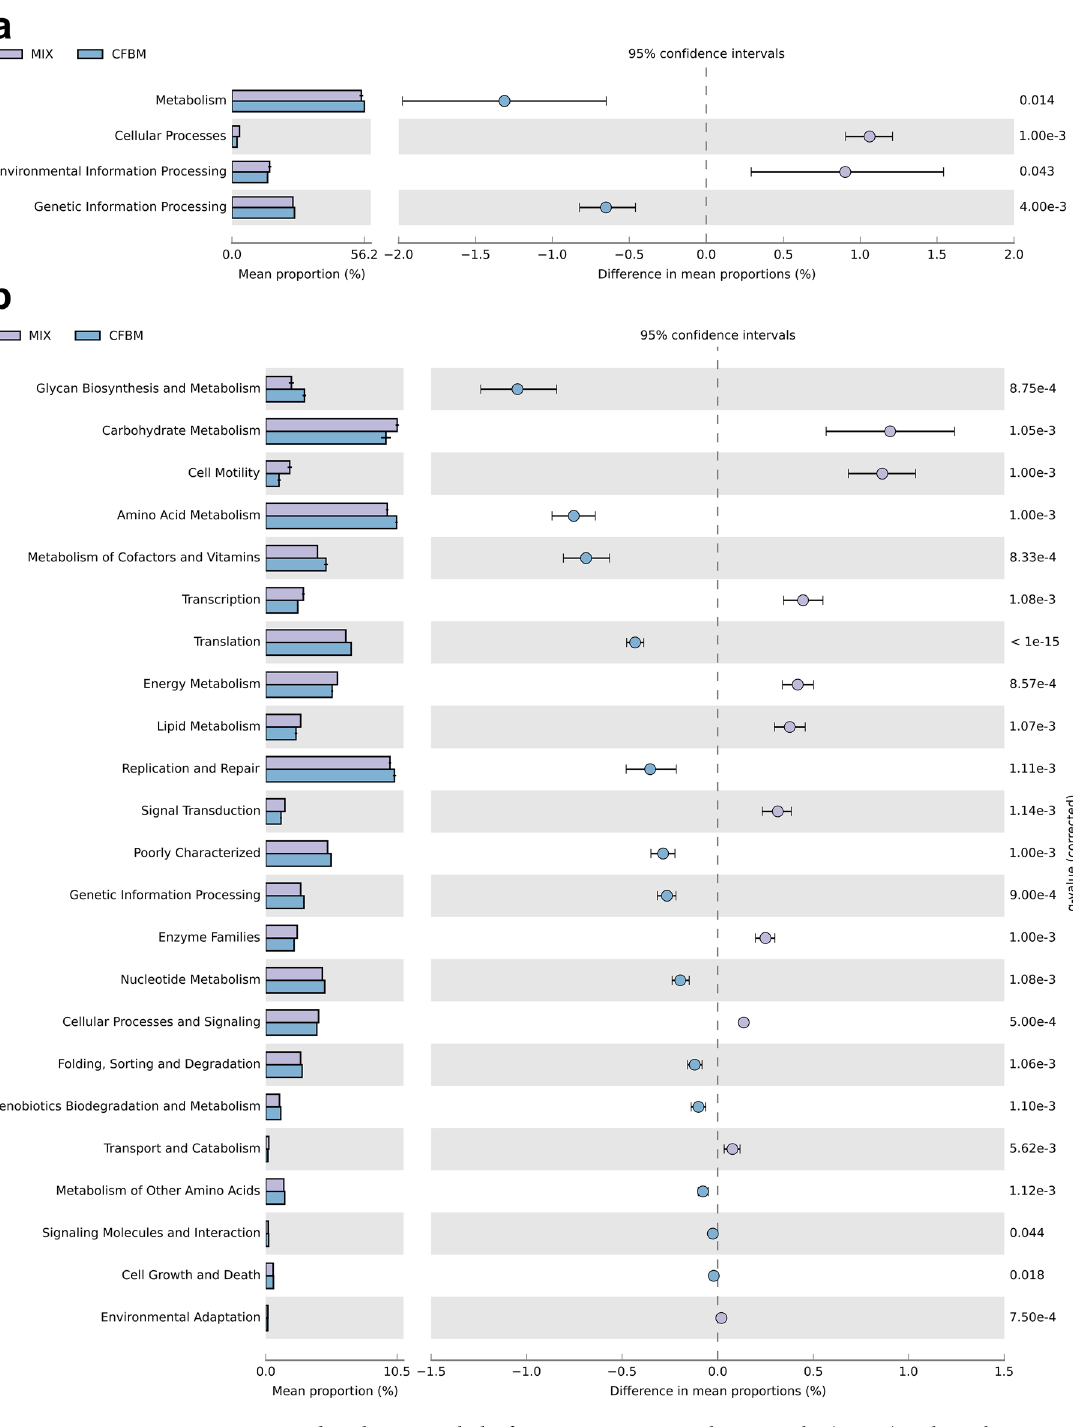
Figure 6. PICRUSt2 predicted GM metabolic functions at KEGG pathway Level 1 ( a , c , e , g ) and Level 2 ( b , d , f , h ). STAMP analysis revealed significantly different metabolic functions between non-cultured MIX inoculum and MIX samples after 24 h of cultivation in four different media: CFBM ( a , b ), FM ( c , d ), GMM ( e , f ), and SM ( g , h ). Samples represent viable bacteria after PMA